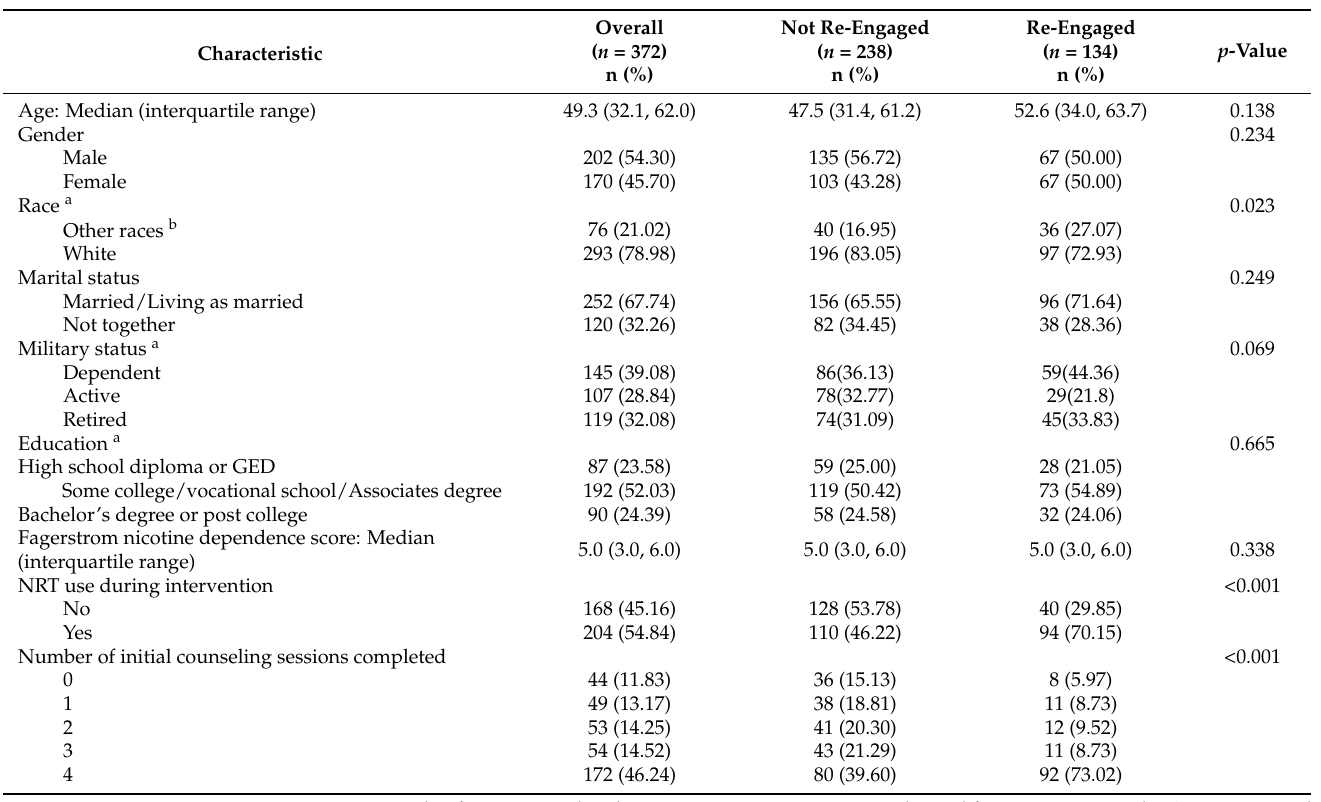
Table 1. Demographic, tobacco use, and initial intervention use overall and by three-month re- engagement.